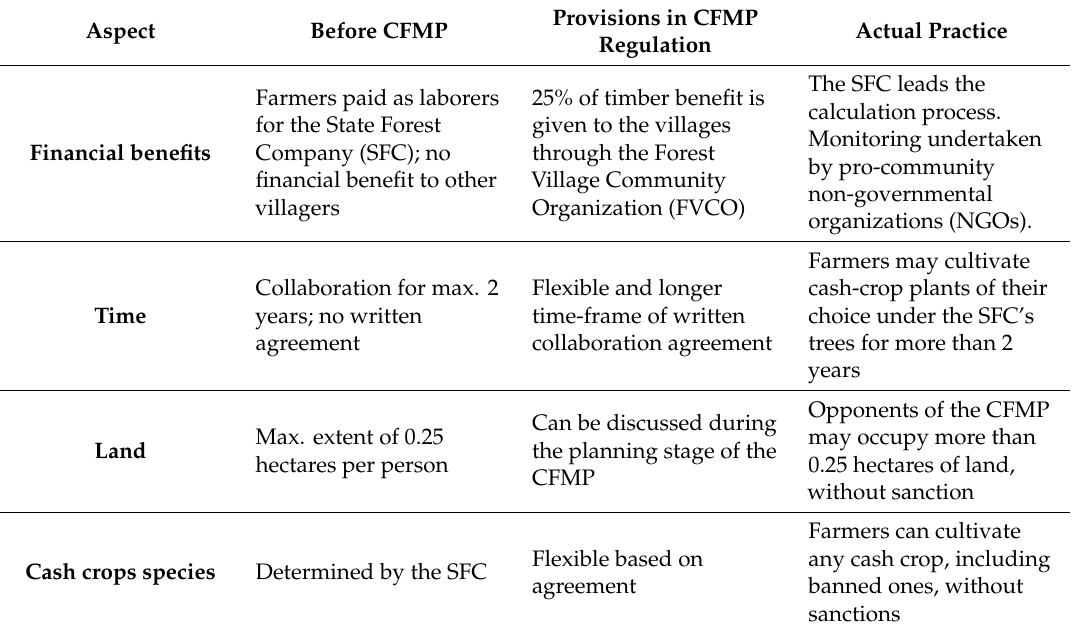
Table 1. Distribution of Collaborative Forest Management Program (CFMP)